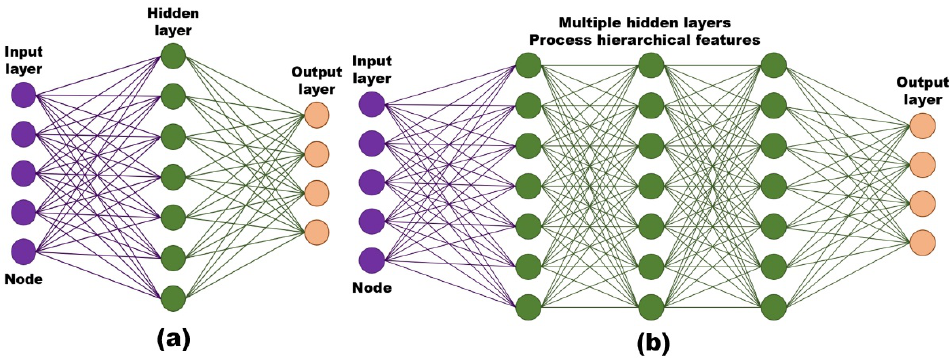
Figure 1. Schematic of (a) shallow neural network and ( b ) deep neural network.